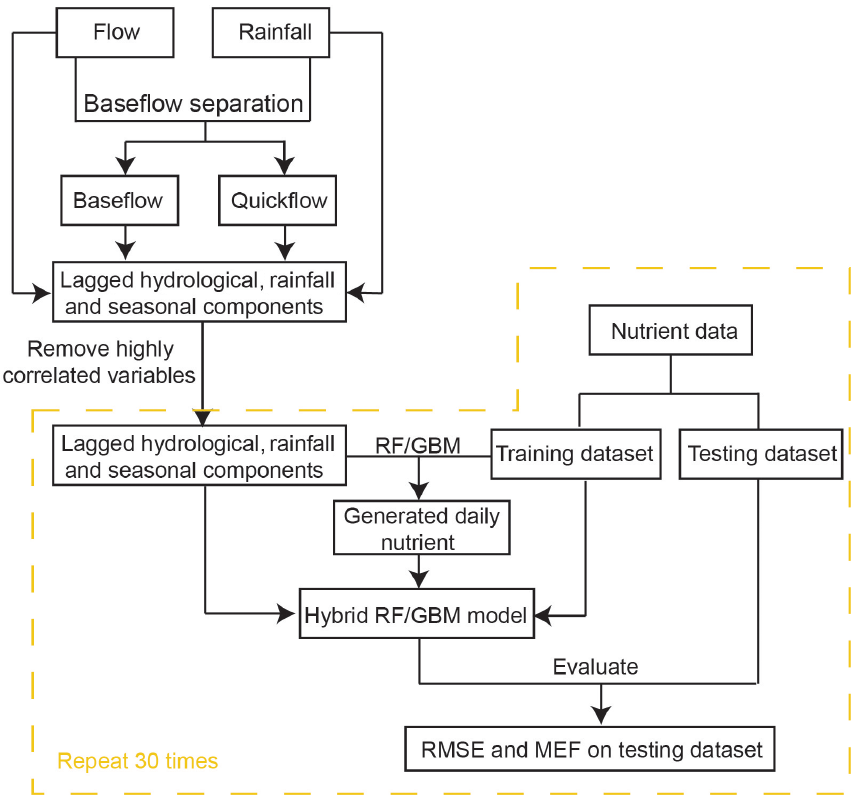
Figure 1. Overall modelling processes of